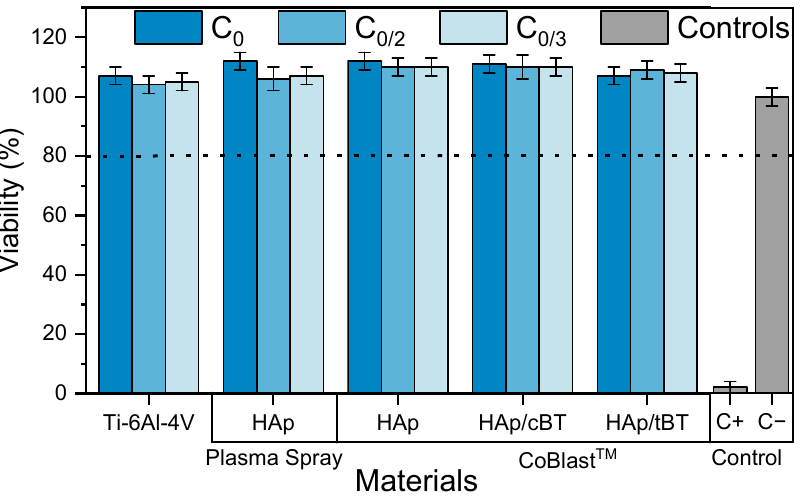
Figure 7. Relative cell viability in cytotoxicity tests of coated and uncoated samples. C 0 is the initial concentration (0.5 cm 2 /mL), C 0/2 and C 0/4 are dilutions by factors of two and four, C+ is the positive (cytotoxic) control and C − is the negative (nontoxic) control, both presented in gray.